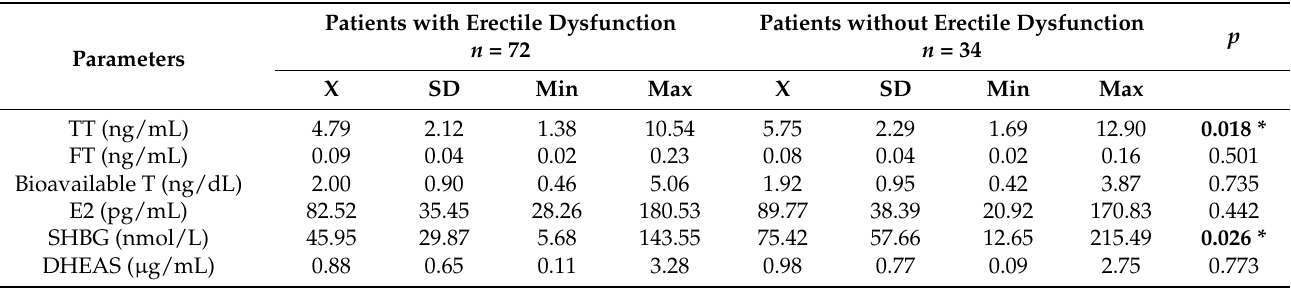
Table 2. Analysis of the relationship between hormonal parameters in men according to the score in the International Index of Erectile Function.